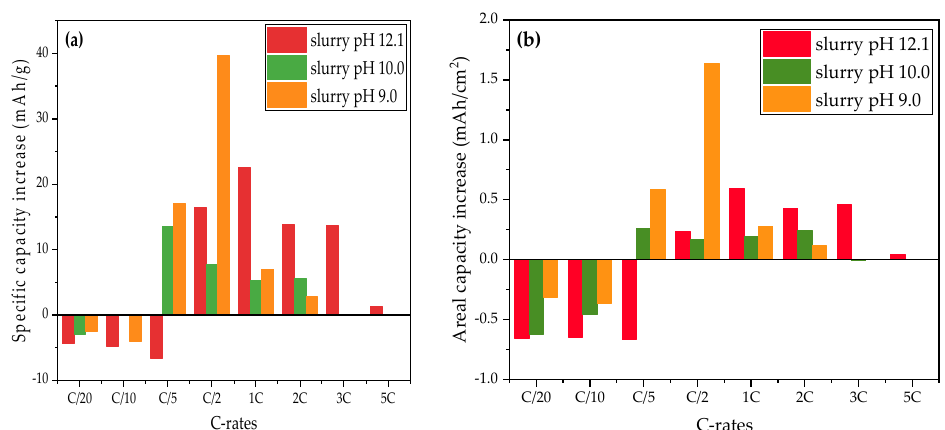
Figure 12. Comparison of ( a ) specific capacity increase and ( b ) areal capacity increase of cells with structured electrodes processed with different slurry pH values compared to cells with unstructured electrodes produced with the same slurry pH value.